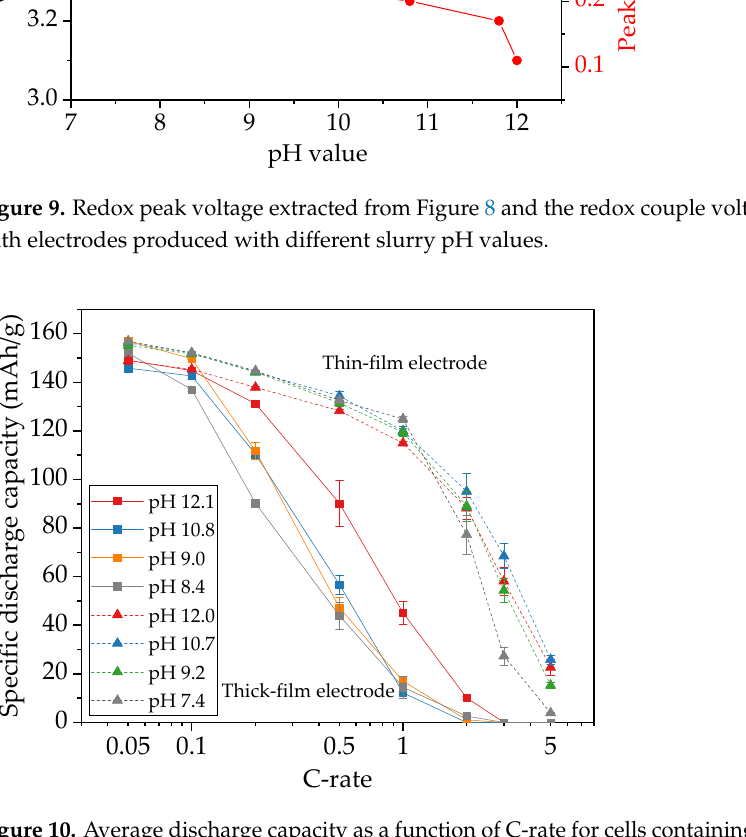
Figure 10. Average discharge capacity as a function of C-rate for cells containing electrodes produced with different slurry pH values.